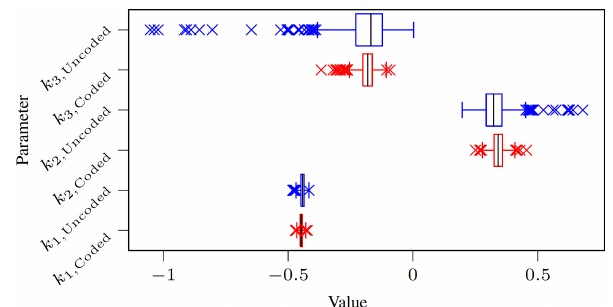
Figure 10. Boxplot comparing the radial distortion parameters k 1 , k 2 and k 3 obtained with the coded and uncoded targets.